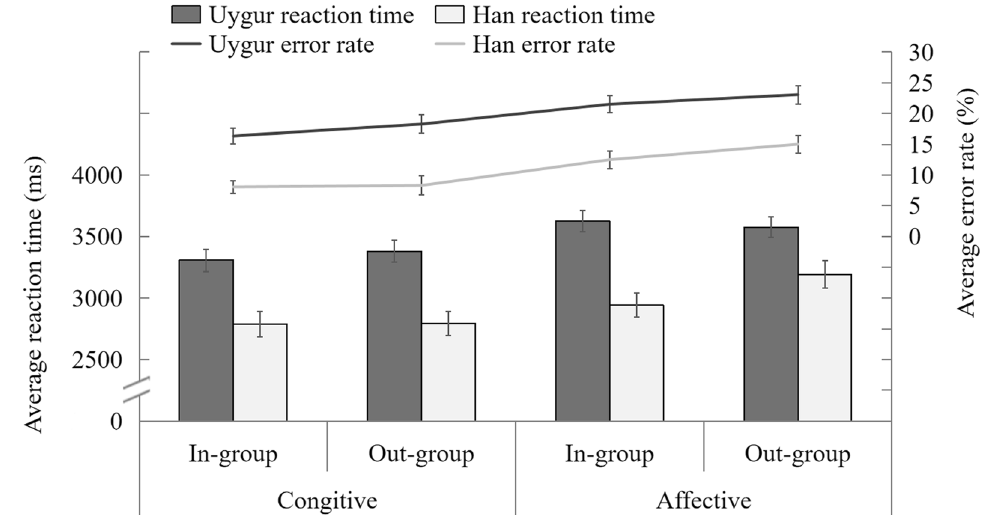
Fig. 5 Average reaction time and the error rate of Uygur and Han Ethnicity under different conditions in Yoni